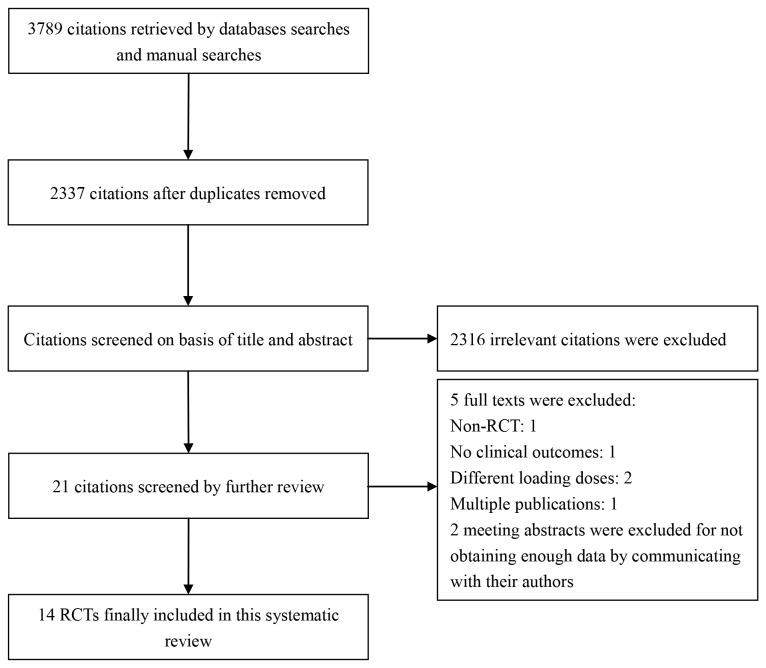
Flow chart of study selection.